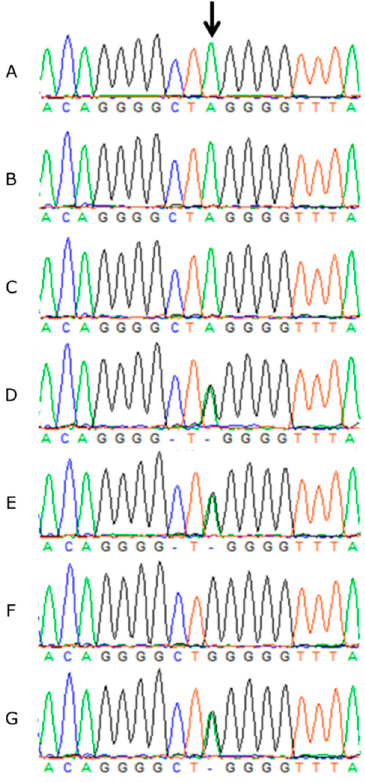
Figure 3. Sanger sequencing traces showing the c.544G>A SNV in NECAP1 in three PRA affected GS DNA ( A,B,C ); the heterozygous unaffected sire ( D ) and dam ( E ); a homozygous wildtype unaffected sibling ( F ), and a heterozygous unaffected sibling ( G ). Table 1. Total allele frequency of NECAP1 single nucleotide variant (SNV) in multiple breeds of dog. Breed NECAP1